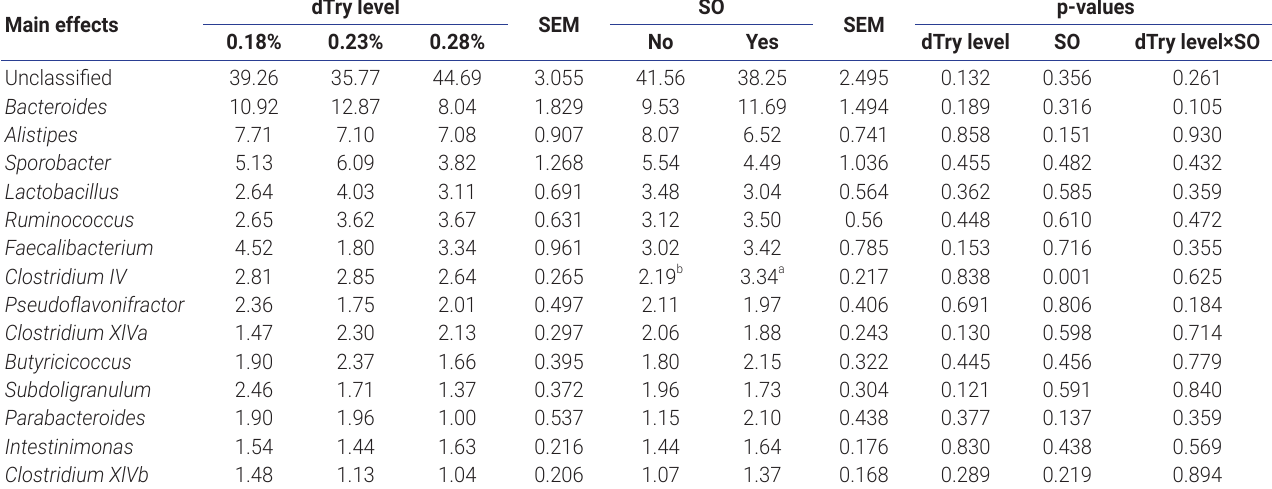
Table 5. ii) Effects of dietary digestible tryptophan and soy oligossacharide supplementation on caecal microbial relative abundances in broiler chickens (at genus